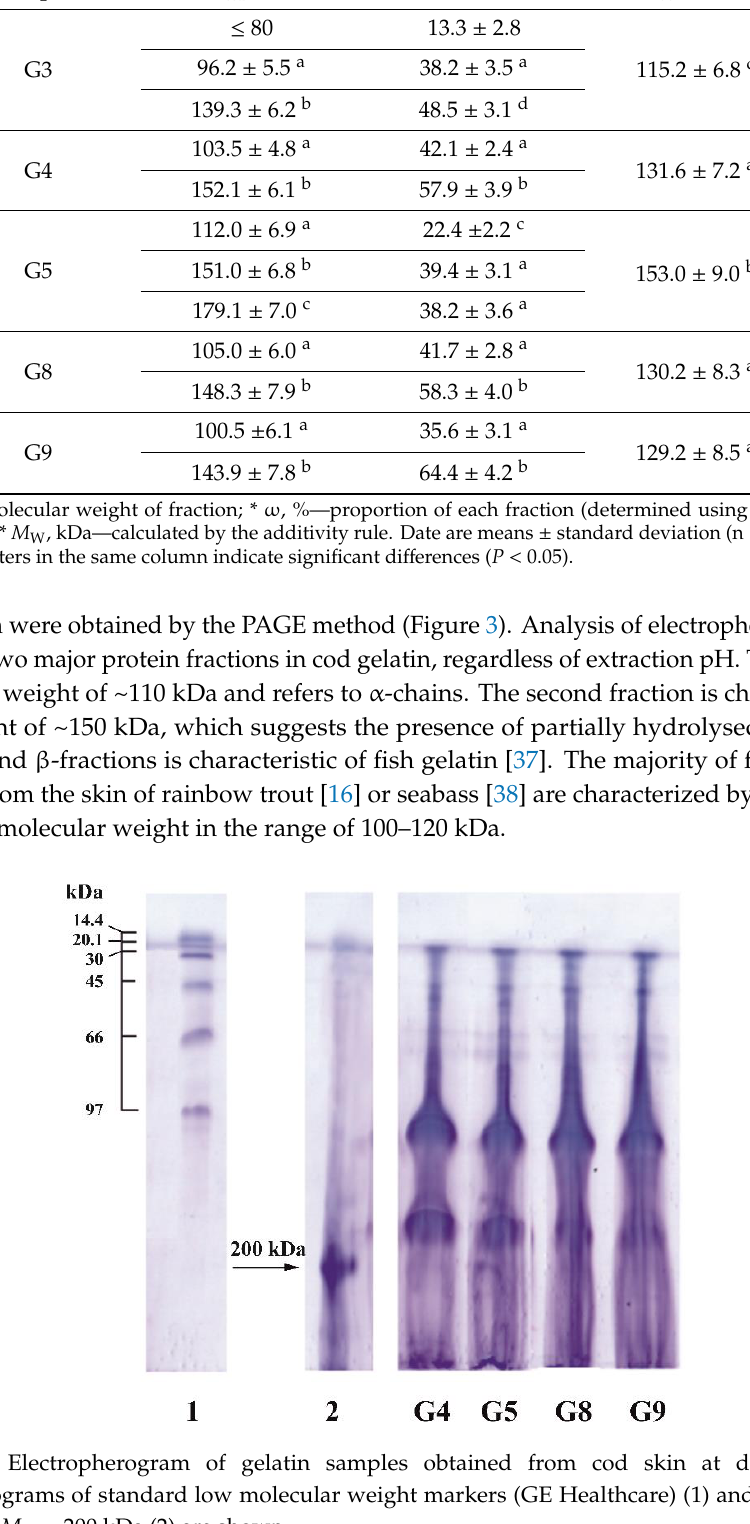
Table 3. Molecular weight distribution of cod gelatin according to the HPLC method.